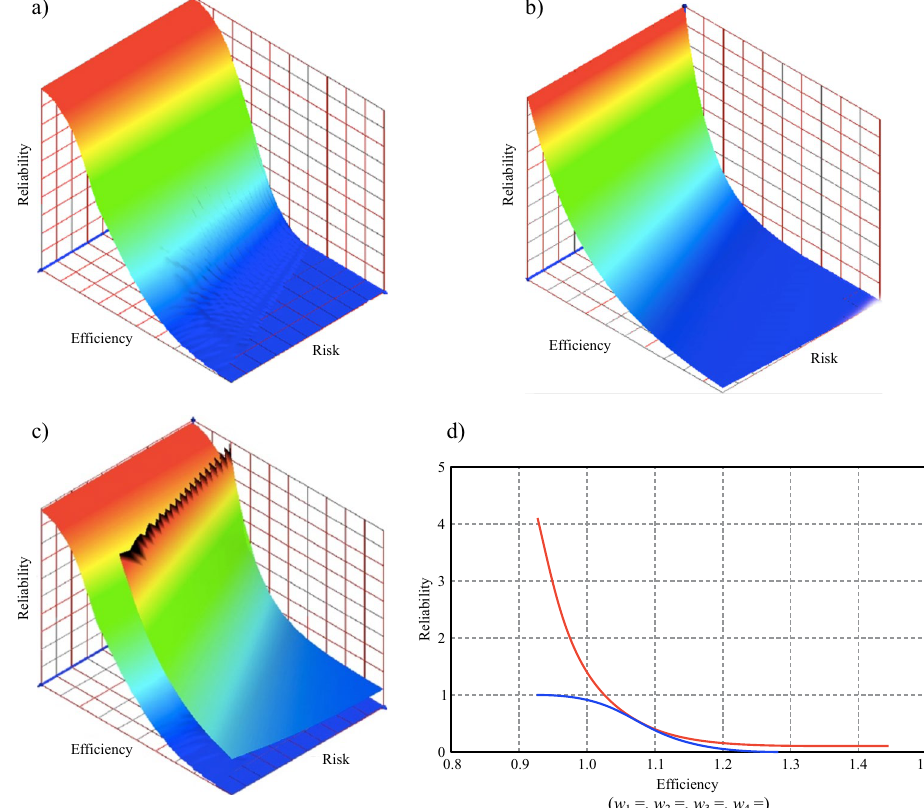
Fig. 2. Allocation scheme of the optimal marginal investment unit: efficiency possibilities (a), utility function (b), surface contact point (c), and optimal solution